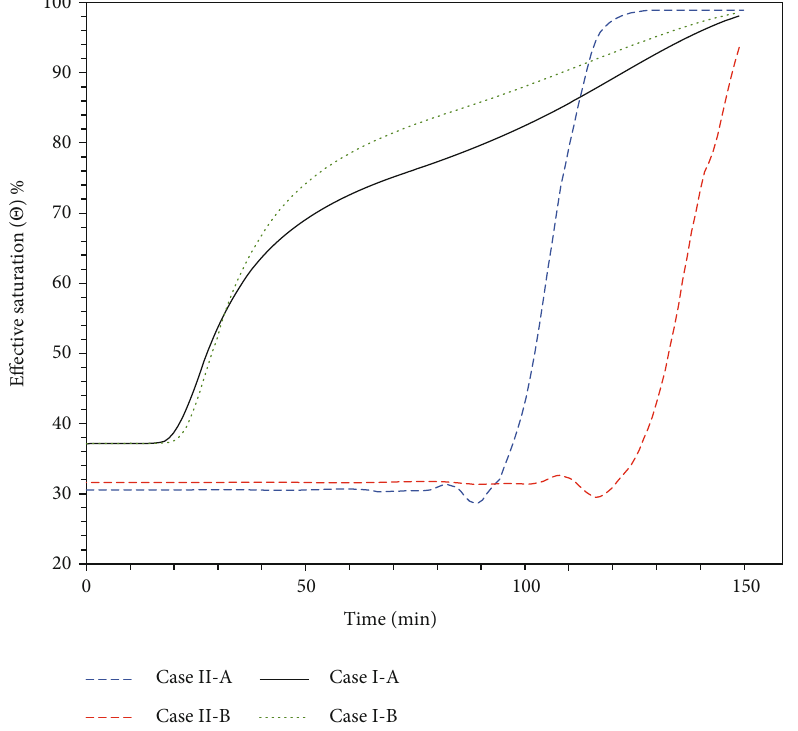
Figure 11: Saturation history of studied cases at unit irrigation